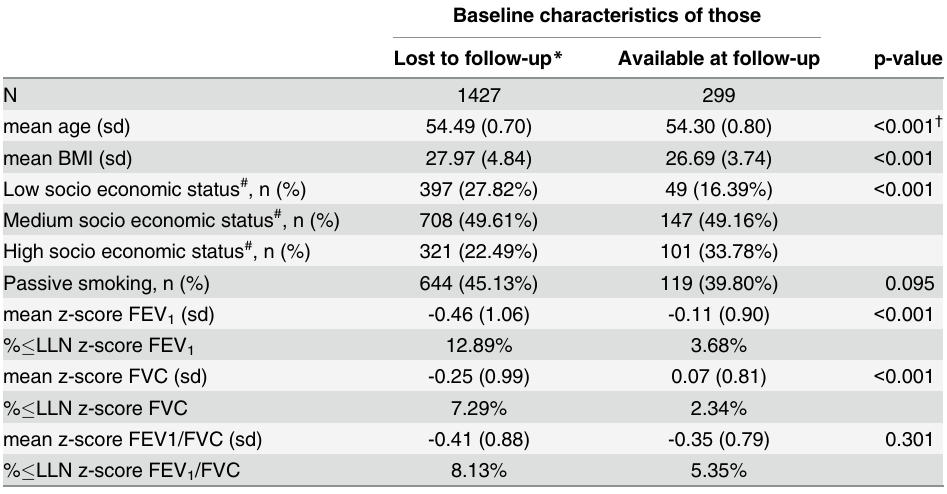
Table 2. Comparison of baseline characteristics of healthy never-smoking women (HNSW) lost to fol- low-up and available at follow-up. Differences in the continuous variables were tested with the two-sample t-test and differences in the categorical variables were tested with Fisher ’ s exact test at the 5% significance level. Baseline characteristics of those Lost to follow-up *